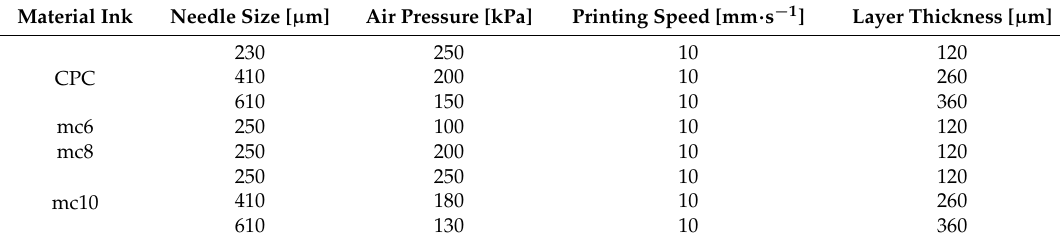
Table 1. Plotting parameters of CPC and mc support